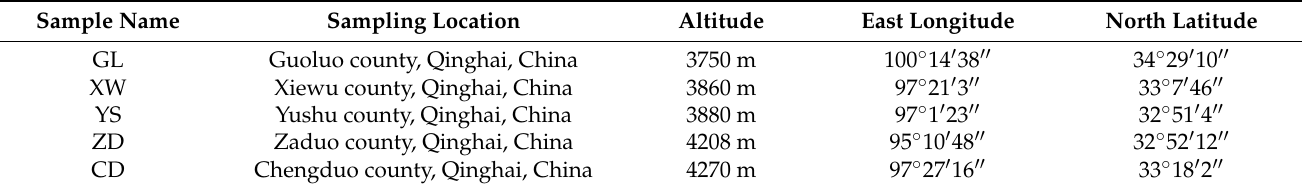
Table 1. The habitat and site of L. rotata from five